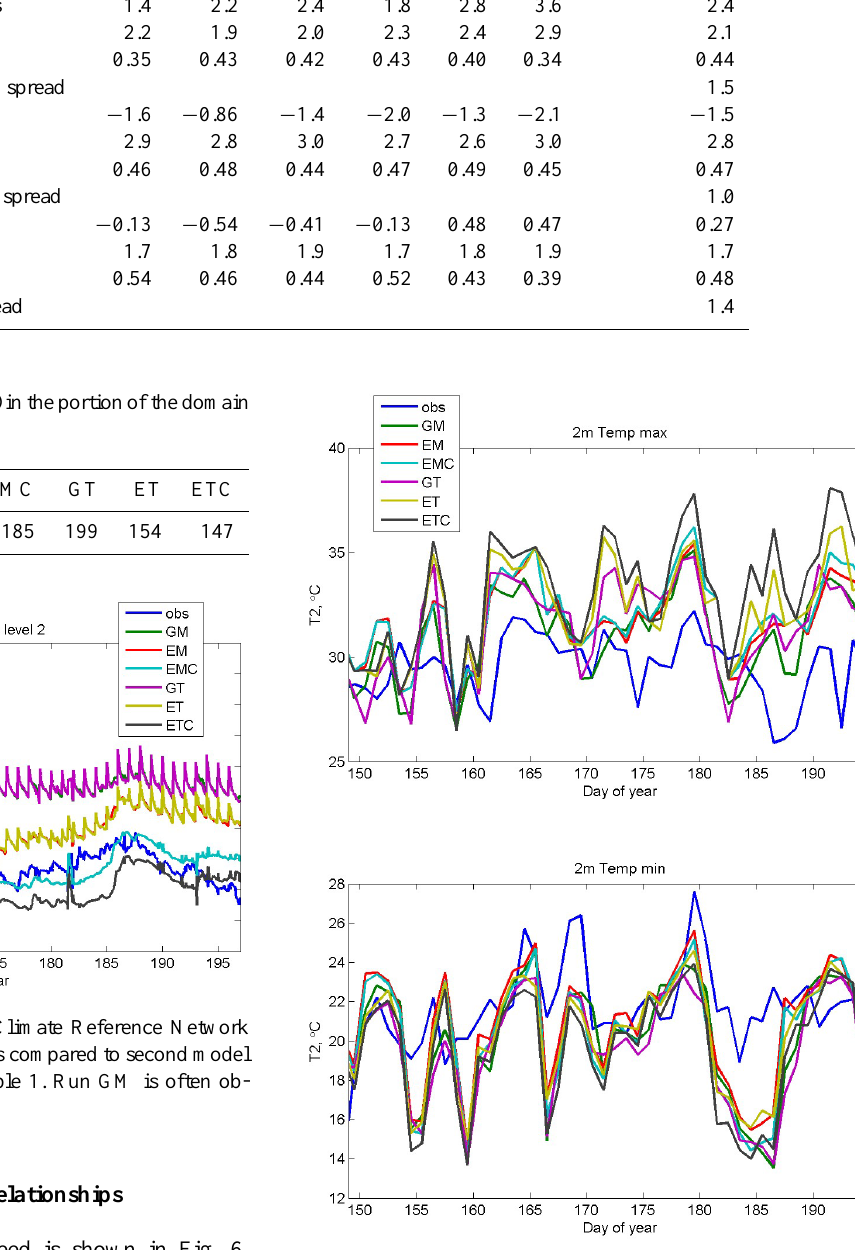
Figure 3: Daily maximum and minimum near-surface temperature averaged over 28 Climate 544 Figure 3. Daily maximum and minimum near-surface temperature Reference Network sites. 545 averaged over 28 Climate Reference Network sites.